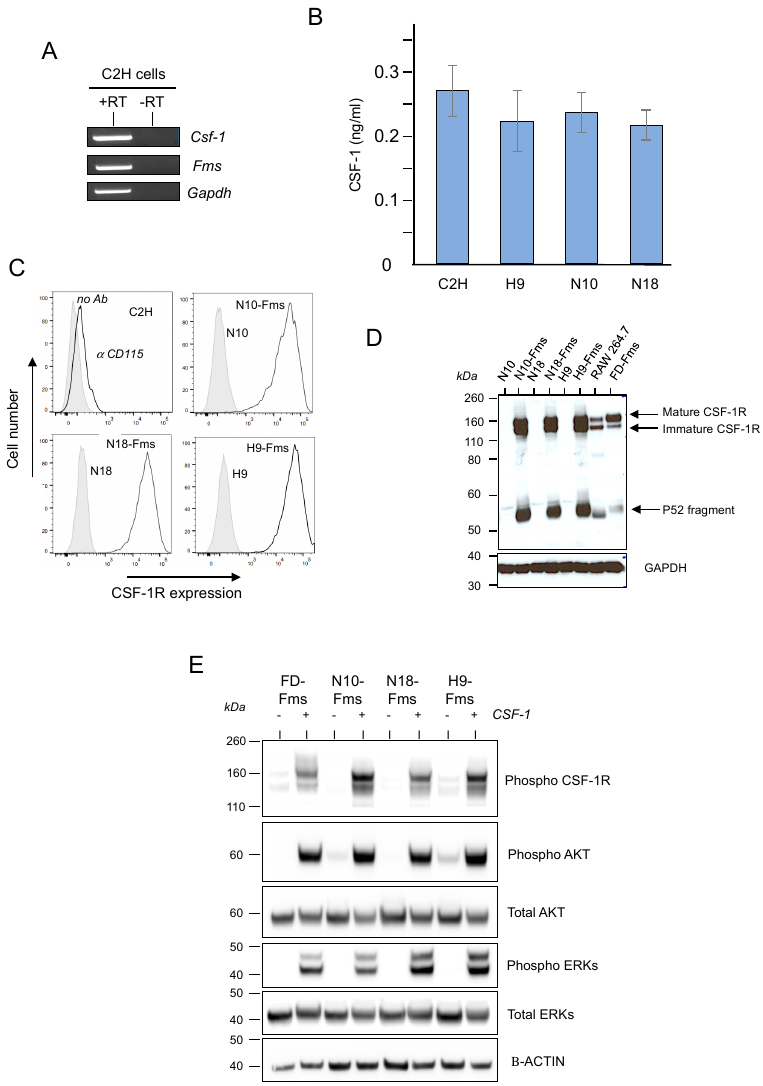
Figure 1. The CSF-1 receptor is functional in C2H murine prostate cells and activates major signaling pathways. ( A ) RT-PCR analysis of CSF-1, CSF-1 receptor (Fms) and GAPDH transcripts in C2H cells. N = 3. Reverse transcriptase (RT) ( B ) ELISA assay to quantify CSF-1 secretion by C2H parental cells and three subclones, H9, N10, and N18. N = 4 ( C ) murine c- fms cDNA encoding CSF-1R was trans-duced in the three subclones by retroviral infection; CSF-1R-expressing cells were isolated by FACS and three cell populations were obtained, called H9-Fms, N10-Fms, and N18-Fms. Cell surface expression was analyzed by flow cytometry. ( D ) Immunoblot shows that CSF-1R protein was expressed and matured as compared to Raw 264.7 and FDCP1-Fms (FD-Fms) myelomonocytic cell lines. ( E ) Western blot analysis shows that CSF-1 stimulation of Fms-expressing prostate cells activates receptor kinase activity and phosphorylation of AKT and p42/p44 ERKs substrates. As a control, activation of myeloid FD-Fms cells by CSF-1 shows similar AKT and ERKs phosphorylation. For all immunoblot images presented throughout this manuscript, the membrane was cut into pieces according to the estimated molecular weight of proteins of interest and probed with the indicated antibodies. All cropped blots were run under the same experimental conditions. Data presented here are representative of at least 3 independent